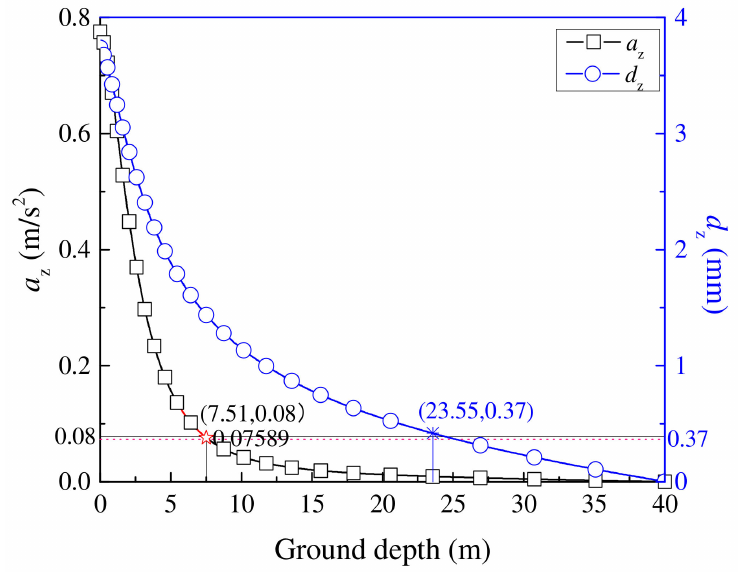
Figure 9. Variations of a z and d z with ground